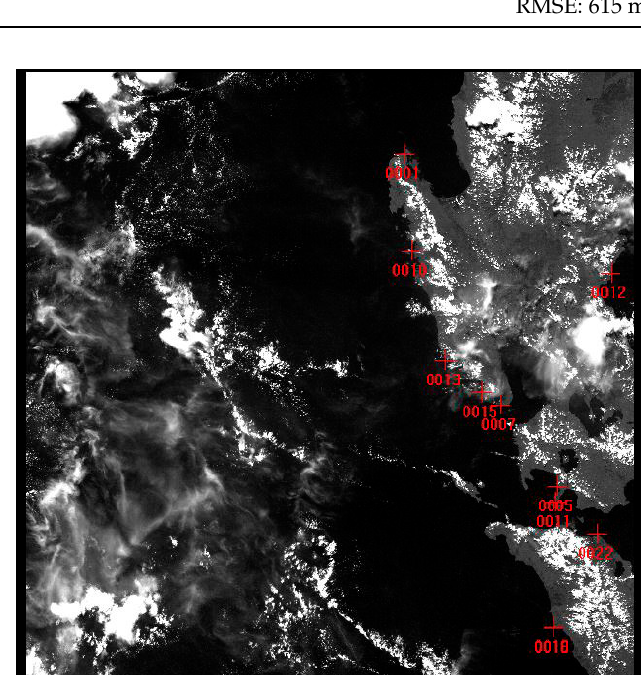
2487.234375 RMSE: 615 m (12.3 pixels) With the selected GCPs, we were able to georeference the original image using both the RPC and GCPs to get a Level 2B product. After that, the georeferencing accuracy was checked using 10 checking points, with an RMSE of 86.7 m. The original georeferencing accuracy was also checked, with the RMSE being 3894.4 m. The checking points are listed in Table 4 and the distribution is shown in Figure 12. Note that the GCPs and checking points were manually selected in two independent processes: GCP selection and precision checking.